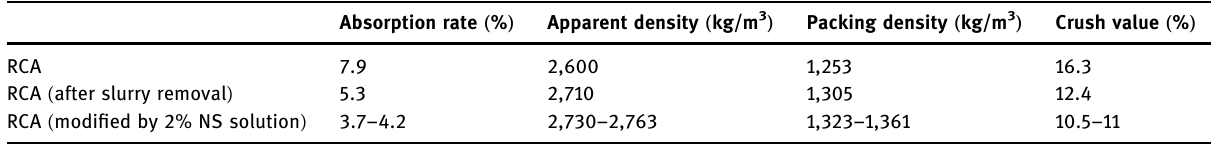
Table 1: Physical properties of the RCA before and after slurry removal Absorption rate ( %